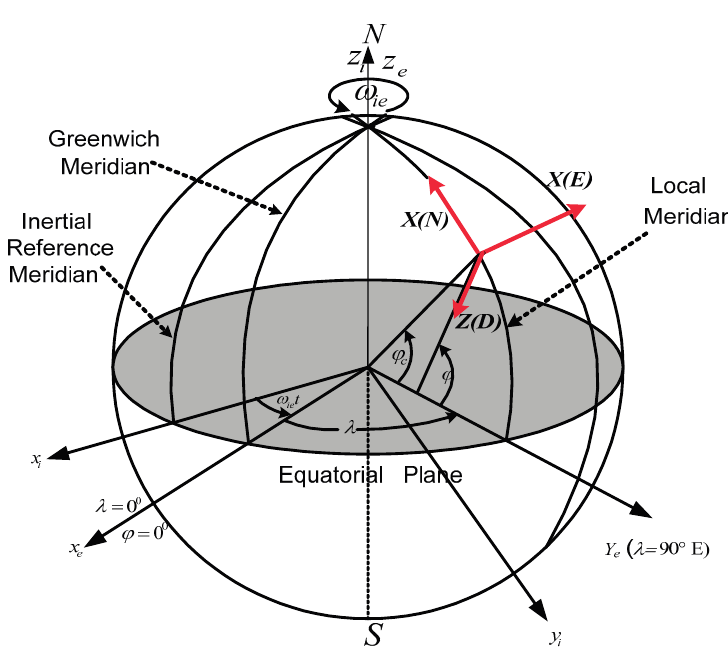
Figure 1. 3D reference frame